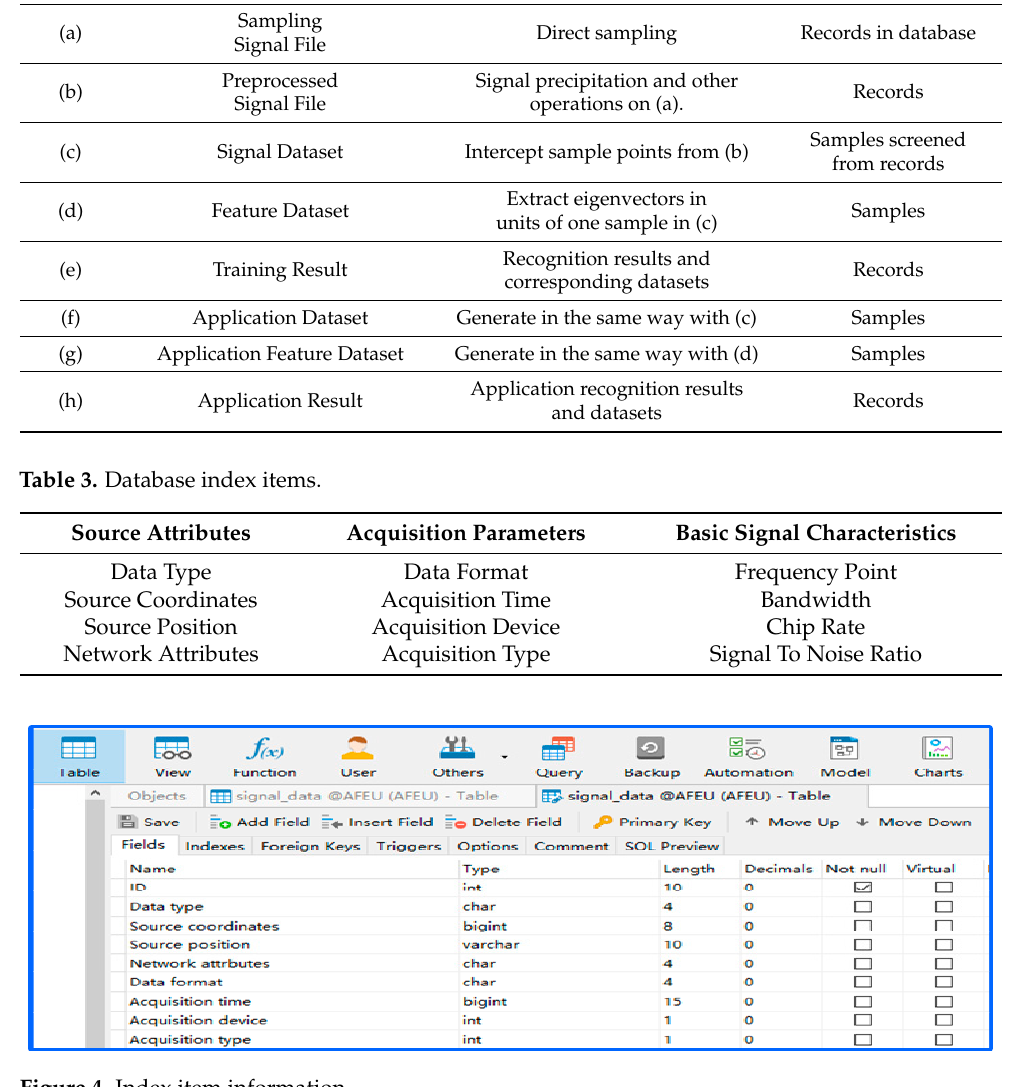
Figure 4. Index item information.